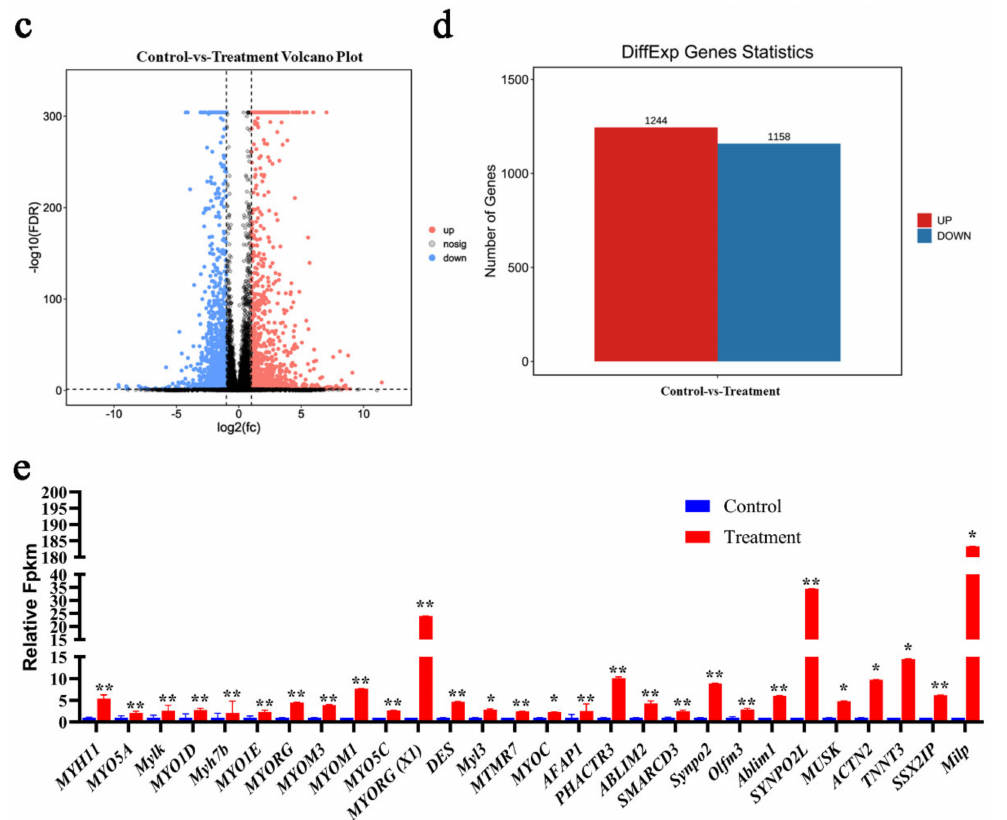
Figure 6. Transcriptome sequencing analysis of BM-MSCs treated with 5-Aza. ( a ) PCA of transcrip- tomic variation. Shapes denoted different groups of the cell samples; colored dots indicated different samples. ( b ) Correlation analysis of different samples. ( c ) The volcano plots map of all DEGs between control cells and treated cells. ( d ) The number of up-regulated and down-regulated DEGs and ( e ) 28 muscle-related DEGs were up-regulated by the treatment of 5-Aza and horse serum in comparison to control cells. Symbol “*” and “**” indicate a significant difference at p < 0.05 and p < 0.01,